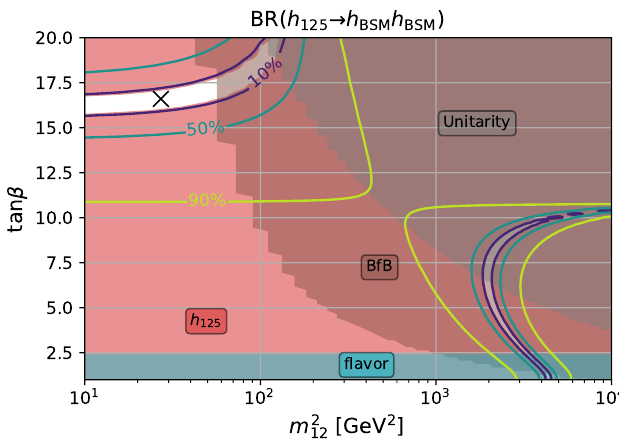
) parameter plane orthogonal to the cH ( Wh light ) benchmark scenario. Figure 26. The ( tan β , m 2 12 BSM The masses are fixed to m = 30 GeV and m = m = 200 GeV and all remaining parameters h BSM A H ± are as given in table 5. The contours indicate BR ( h ) and the × marks where 125 → h BSM h BSM this plane touches the mass plane of the cH ( Wh light ) scenario. The shaded regions are excluded by BSM existing theoretical constraints — boundedness from below and perturbative unitarity — as well as h 125 measurements and flavor